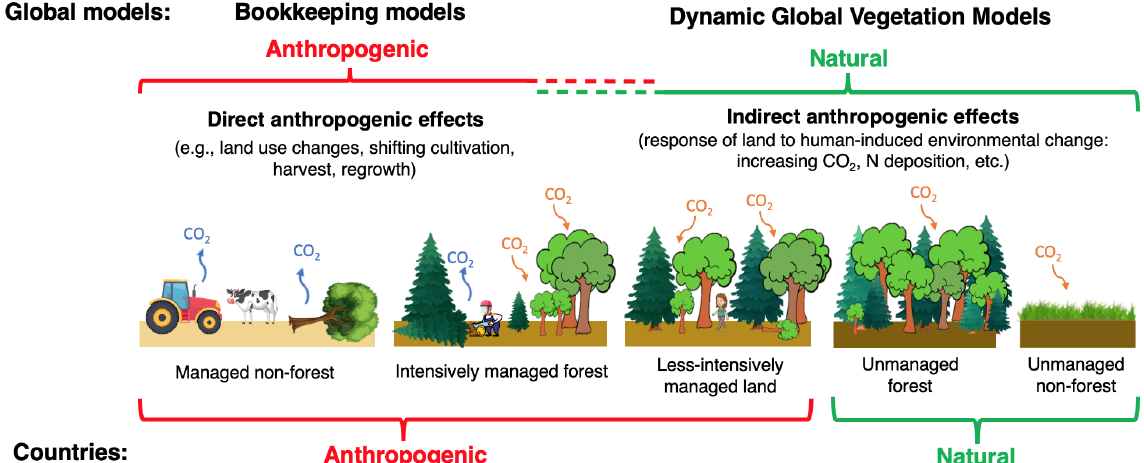
Figure 1. Conceptual illustration of the different approaches for estimating the anthropogenic and natural land CO 2 fluxes by global models used in the Global Carbon Budget (bookkeeping models and dynamic global vegetation models, DGVMs) and by countries’ national GHG inventories (NGHGIs). Bookkeeping models consider as anthropogenic only direct human-induced fluxes from land-use change, such as from deforestation, shifting cultivation, wood harvest, and regrowth after harvest or abandonment of agricultural lands. By contrast, countries in their NGHGIs generally consider as anthropogenic all the fluxes occurring on a larger area of managed forest than the one used by models and include most of the indirect human-induced effects on this area that models consider natural (i.e. the natural response to human-induced environmental changes such as increased CO 2 atmospheric concentration and nitrogen deposition, which enhance tree growth). NGHGIs do not consider fluxes from unmanaged lands. Note that the figure is a simplification: DGVMs can also estimate the anthropogenic flux, but here only the natural fluxes are shown (see Methods); not all NGHGIs include all indirect effects in managed land; other differences between BMs and NGHGIs exist that are not included in this figure, e.g. on the representation of forest management and forest